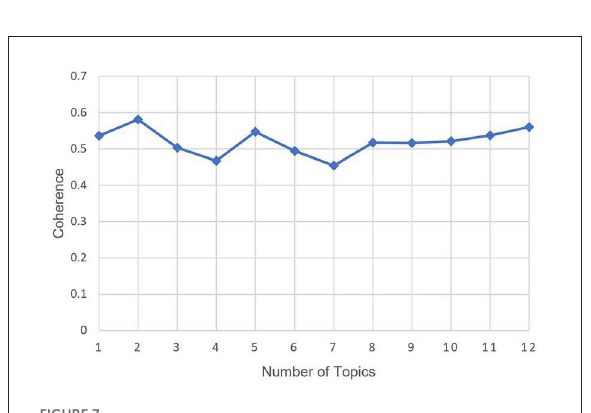
FIGURE7 Relationship between the number of topics and the coherence in fear